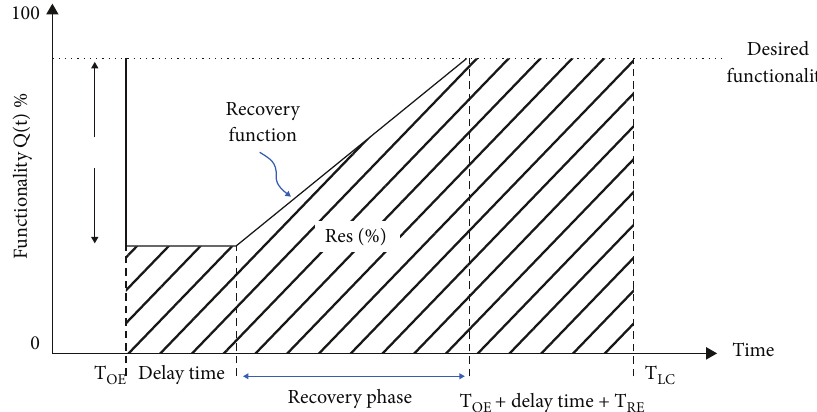
Figure 4: Schematic of functionality curve that commonly adopted